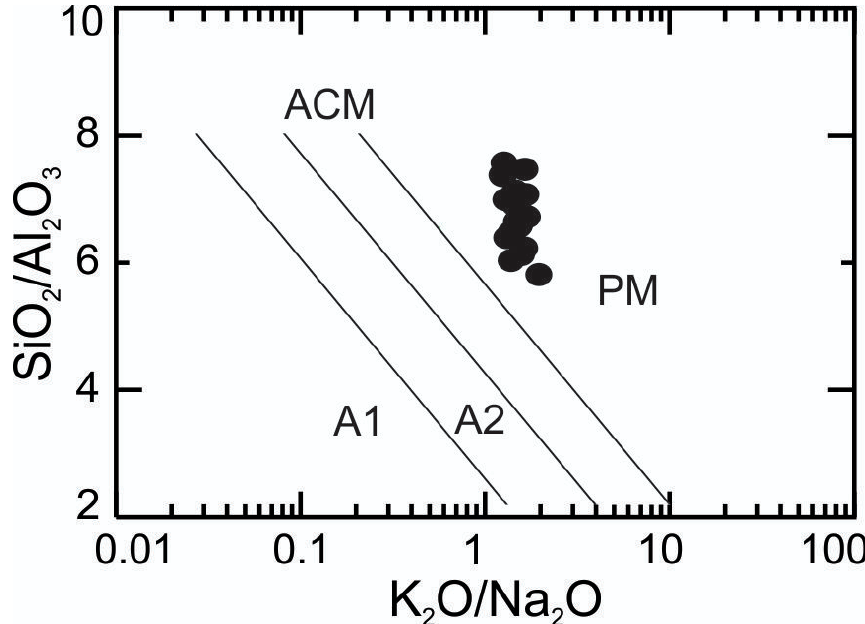
Figure 13. SiO 2 /Al 2 O 3 versus log (K 2 O/Na 2 O) tectonic discrimination diagram [58] for the Brahmaputra River sediments. Brahmaputra River sediment samples are represented by the black dots. A1: arc setting, basaltic and andesitic detritus; A2: evolved arc setting, felsic ‐ plutonic detritus; PM: passive margin; ACM: active continental margin.